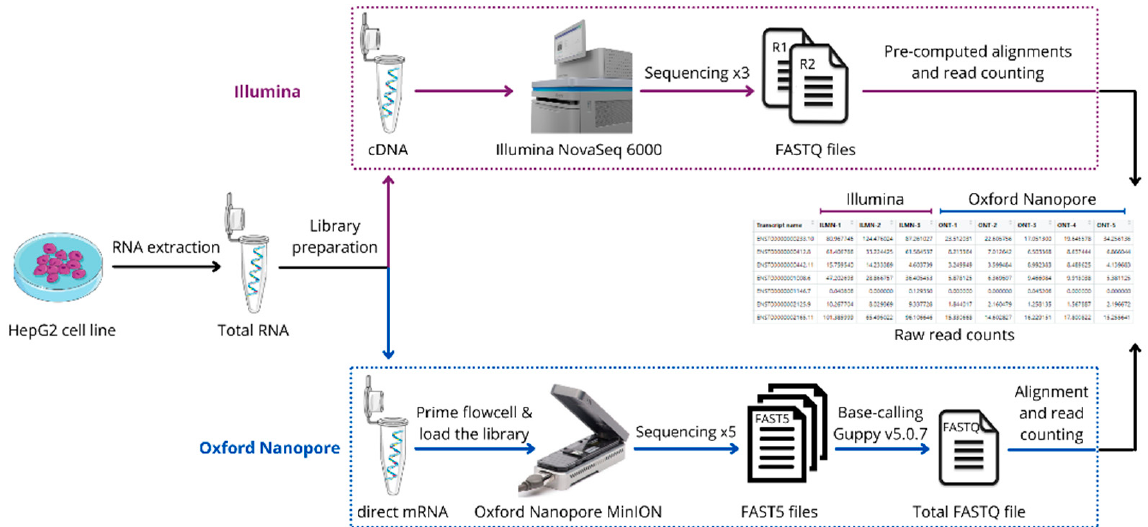
Figure 1. The overall workflow of the experiment. RNA was extracted from the HepG2 cell line and technical replicates were performed using Illumina NovaSeq 6000 (3 replicates) and Oxford Nanopore MinION (5 replicates). Expression of protein-coding transcripts was quantified using Salmon.